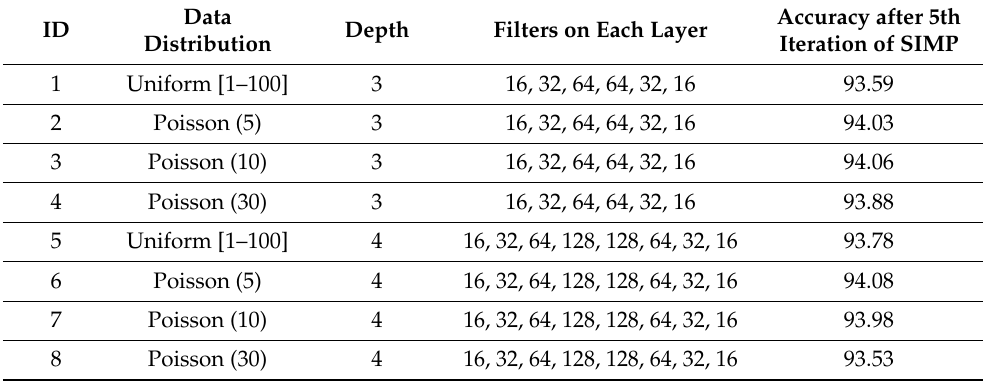
Table 5. Binary accuracy score for the Res-U-Net depends on model parameters on the Dataset #1.